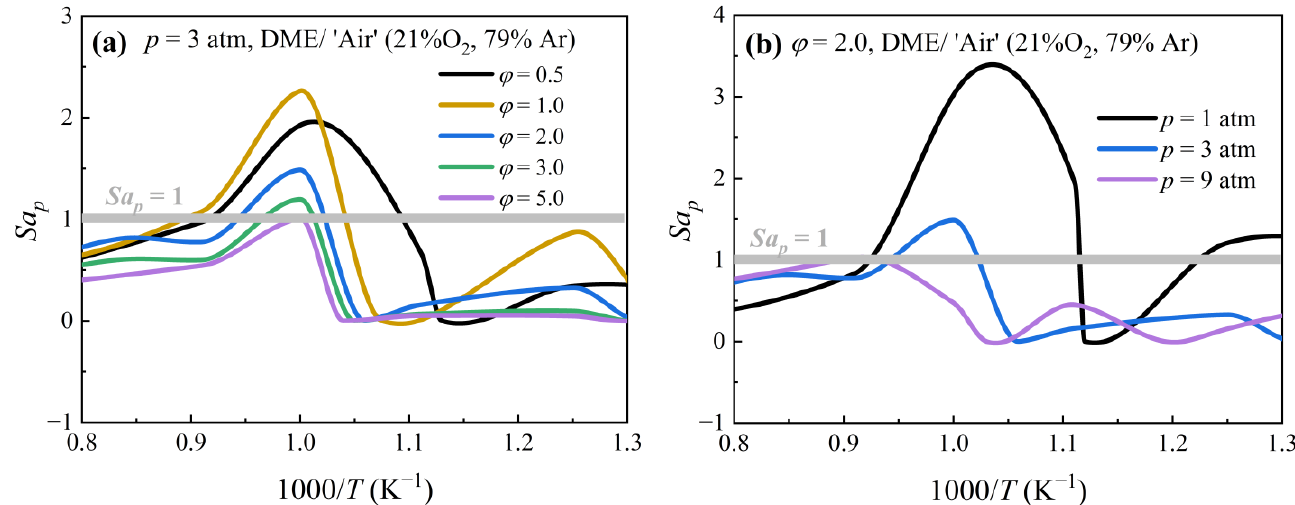
Figure 10. Sankaran number of DME/‘air’ mixtures with different equivalence ratios at different pressures. ( a ) Equivalence ratio dependence. ( b ) Pressure dependence.